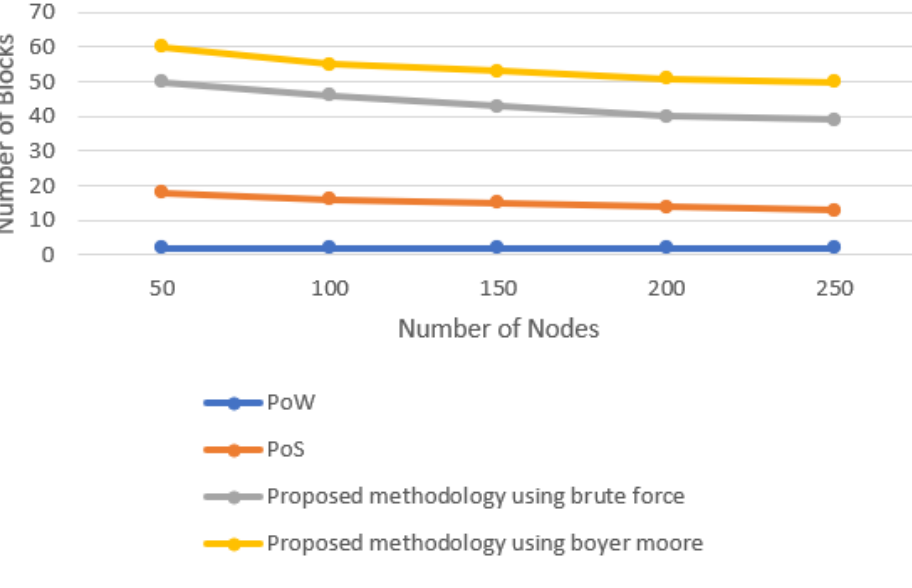
Figure 5. Block generation for 20-min time